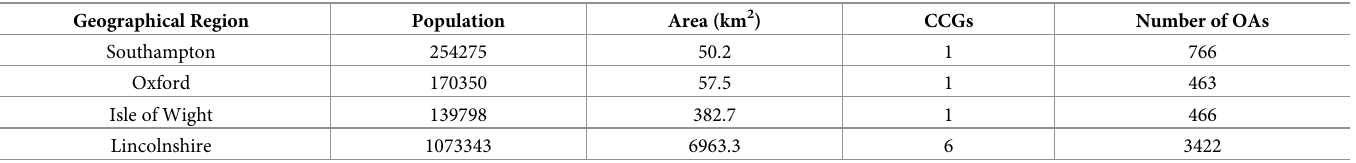
Table 2. Key statistics of the considered geographical regions. Geographical Region